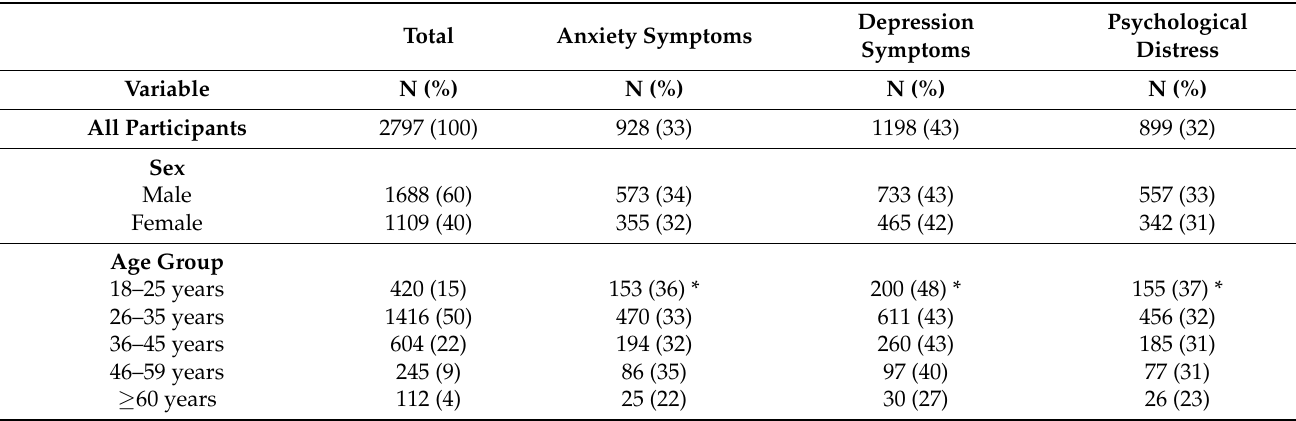
Table 1. Background Characteristics of Study Participants Stratified by Anxiety and Depression